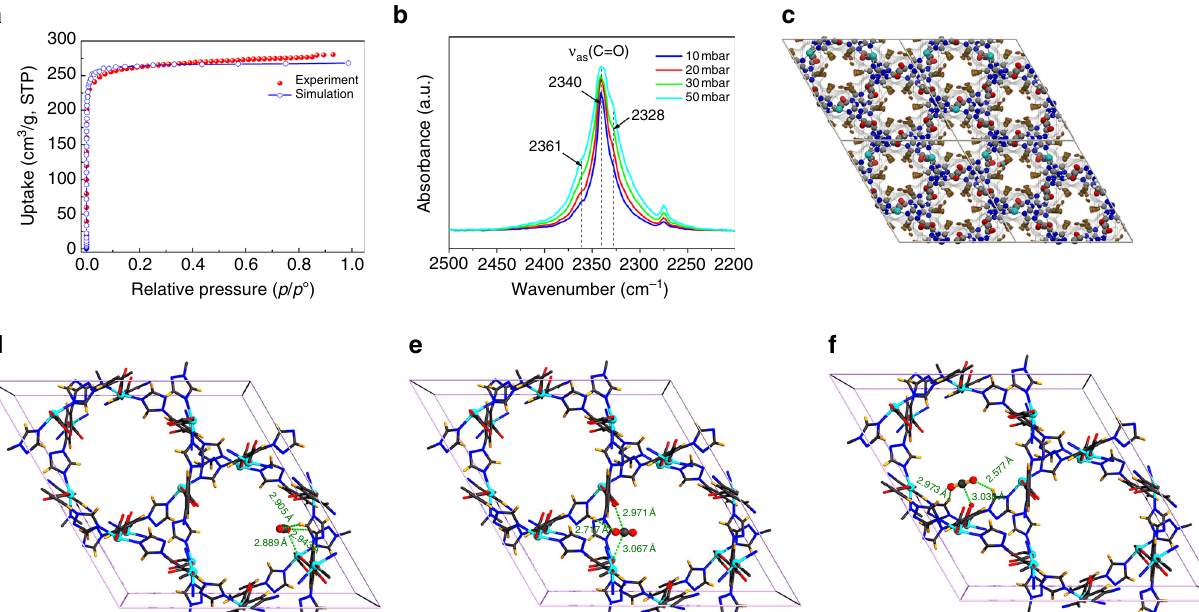
Fig. 4 Mechanism of CO 2 adsorption of FJI-H14. a Experimental and simulated excess CO 2 adsorption isotherms at 195 K. b Background-subtracted FTIR spectra of CO 2 adsorbed on FJI-H14 at decreasing equilibrium pressure. c Density picture of adsorbed CO 2 (1 CO 2 at 273 K), which is shown as a volume rendered mode. d – f represent three preferential CO 2 locations in FJI-14 obtained from GCMC simulation and DFT